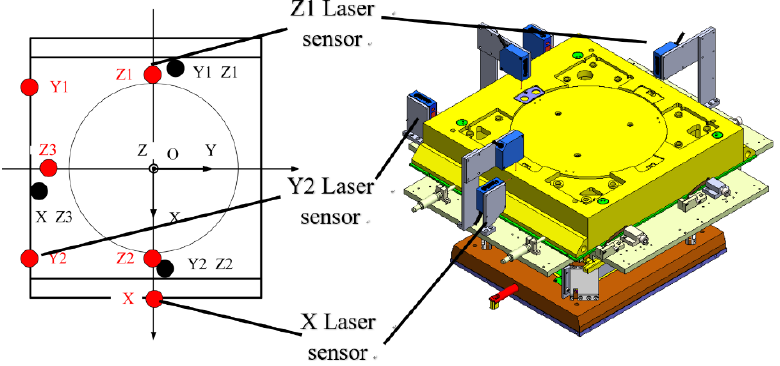
Figure 5. Schematic diagram of the calibration system and physical diagram of the calibration fixture consisting of laser sensors.